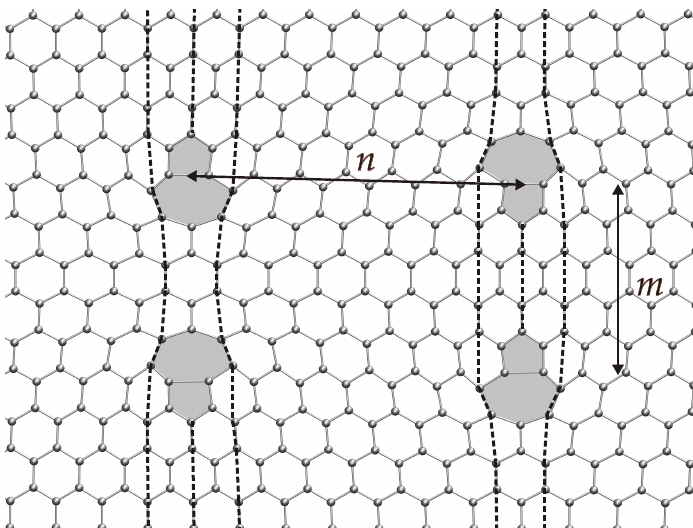
Figure 9. Deformed configurations of periodic quadrupolar arrangement of discrete dislocations for the harmonic solution exhibiting pentagon– heptagon core structures ( n = 15, m = 11).